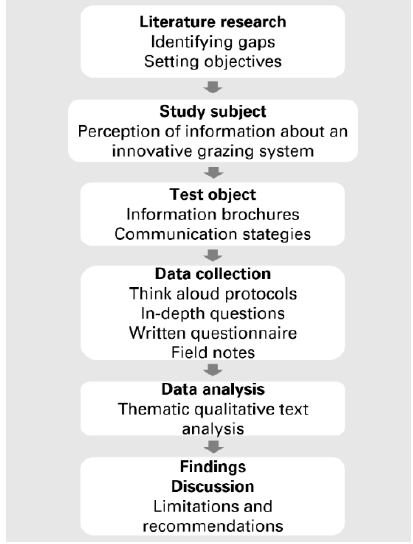
Figure 2. Study design.